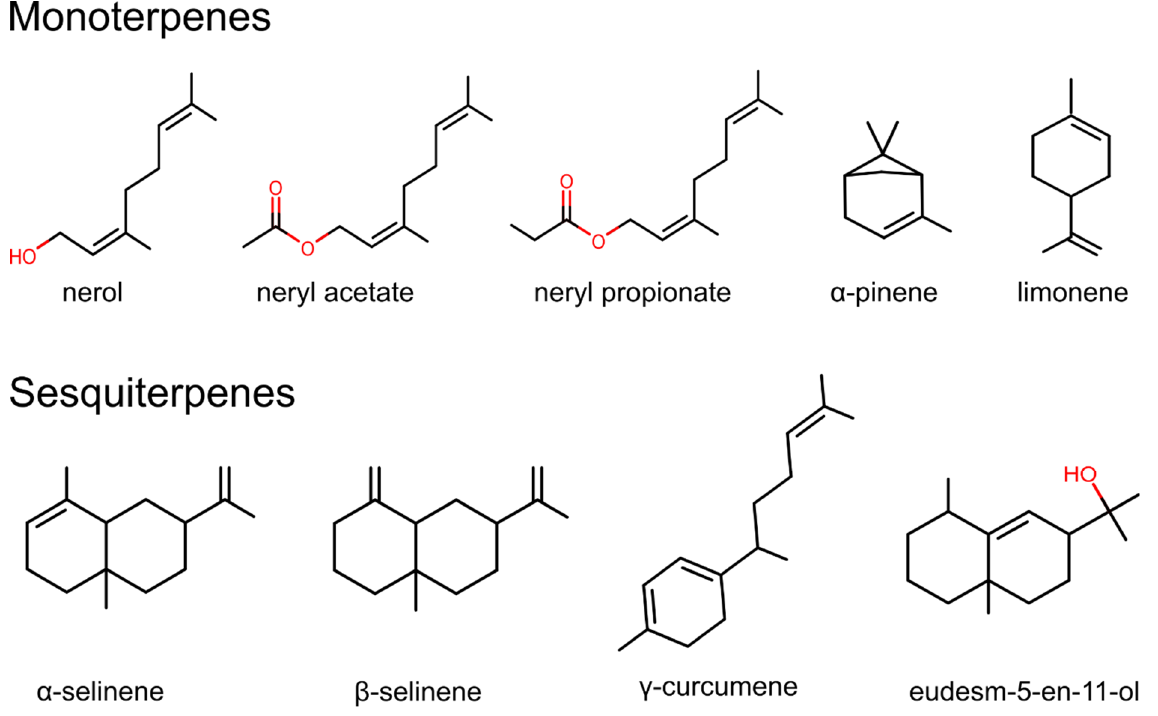
Figure 4. Major bioactive compounds from Helichrysum italicum essential oils.